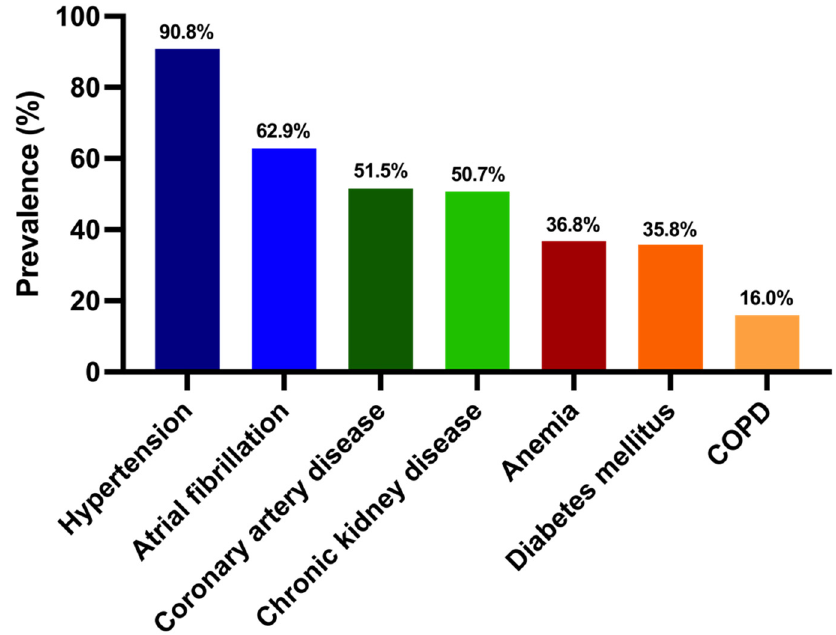
Figure 1. Prevalence of comorbidities in our cohort.